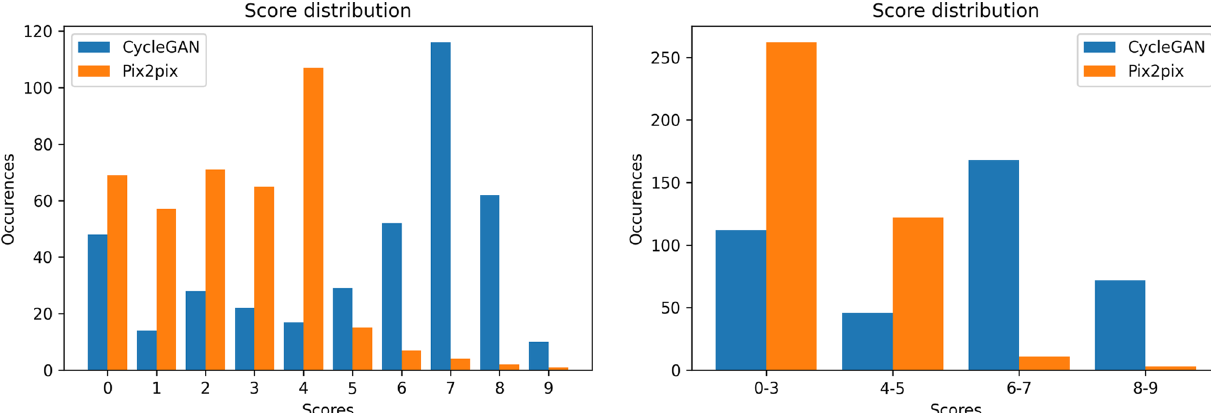
Fig. 3 (left) The distribution of grades for the 400 test drums for both CycleGAN and Pix2Pix (baseline)—averaged among all four independ- ent evaluators and over all four dimensions. We rounded the results to the closest integer to make the plot more readable. The higher the grade, the better the sample will sound. Samples with grades 0–3 are generally silent or very noisy. In samples graded 4–5, few sounds emerge, but they usually could be more pleasant to listen to and coherent. Grades 6–7 identify drums that sound good and are coherent but not continuous: they tend to follow the bass line too closely. Finally, samples graded 8 and 9 are almost indistinguishable from real drums in terms of sound and timing. (right) In labeling non-graded samples, we, therefore, trained a multi-logistic regression model with both the STOI-like and the FID-based features to predict what of the four grade buckets the graders would assign the sample to. The model accuracy on the test set was 87% for CycleDRUMS and 93% for Pix2Pix. Given this pretty good result, we could then use this trained logistic model to label 14,000 different 5s fake drum clips produced from as many real bass lines using both CycleGAN and Pix2Pix (baseline). The histogram above shows the distribution of the predicted class for these